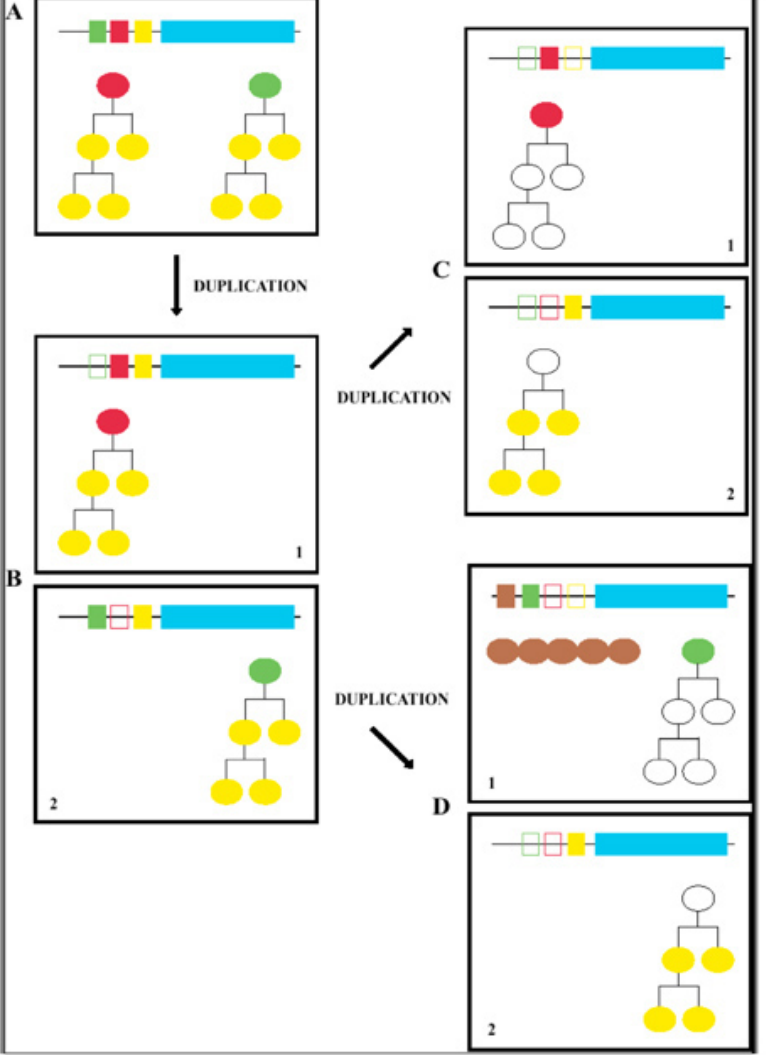
FIGURE 10. A scenario for the evolution of neural bHLH genes. (A) The ancestral situation: a single gene is expressed in two different neural lineages both in already-determined neural precursors and their daughter cells. The gene would control the behaviour and the fate of the precursors and their daughter cells, including cell survival and proper differentiation. The expression of the gene in the different cells is controlled by specific regulatory elements (green and red elements direct expression in specific precursors and yellow in the daughter cells). The structure of the gene is schematised as in Fig. 9. (B) A duplication of the gene has occurred, followed by subfunctionalization. The two duplicates are expressed in complementary patterns, the summed expressions of the genes correspond to the expression of the ancestral gene, therefore nonfunctionalization of either of the two copies is prevented. The two duplicated genes show neural subtype specificity as they are only expressed in one particular neural lineage. Nevertheless, the function of the proteins has not been changed and the two genes, therefore, perform identical functions. (C) The situation that may result from the subsequent duplication of one of the genes in (B), followed by subfunctionalization. In this case, the «ancestral» expression pattern has been partitioned such that one duplicate is only expressed in the precursor and the other only in the daughter cells. Again, the two duplicates are required to perform the function of their single ancestor. (D) As in (C). Subfunctionalization by preventing nonfunctionalization of either of the copies allows neofunctionalization to occur: the acquisition of a new regulatory element (brown) allows expression in naive ectodermal cells and, hence, an involvment in neural determination (proneural function). This may have only occurred in the evolutionary lineage that leads to nematodes and